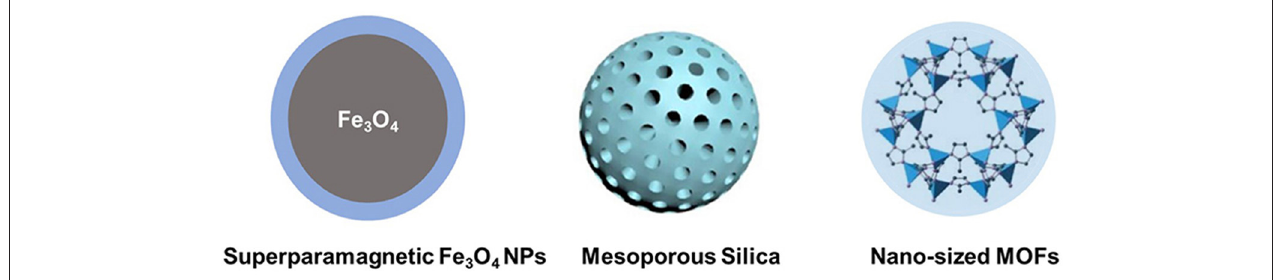
FIGURE 4 | Types of inorganic nanoparticle-based delivery systems for inner ear drug